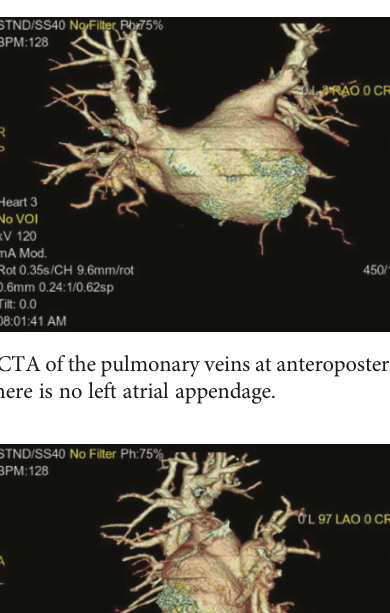
Figure 4: Transesophageal echocardiogram (TEE) at aortic valve level, 19-degree angle midesophageal view shows the pulmonary vein but the absence of the left atrial appendage at the usual anatomical location marked with an asterisk ( ∗ ).